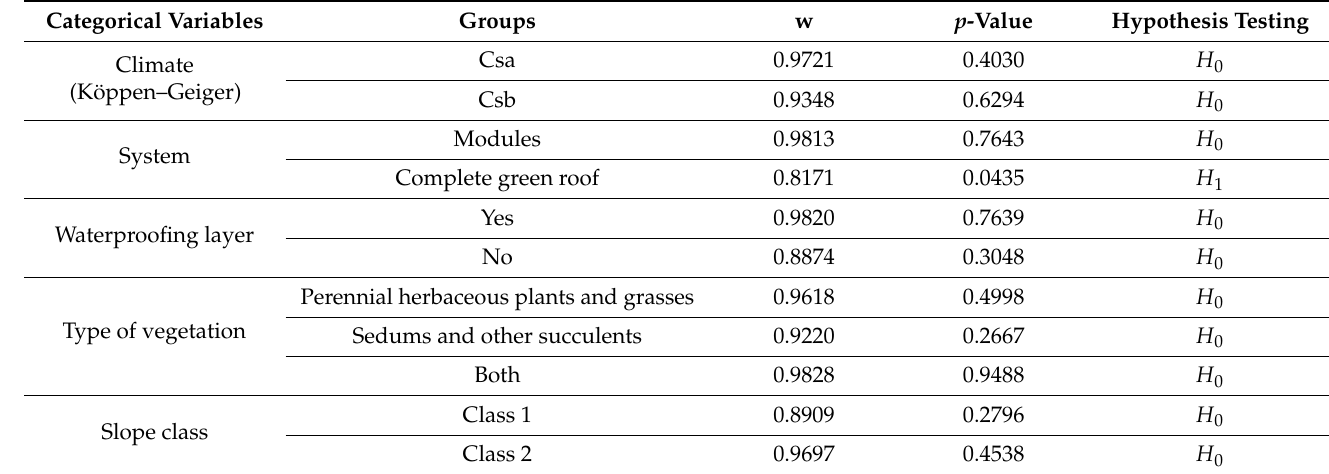
Table A4. Shapiro–Wilk test results for runoff coefficient ( − ).